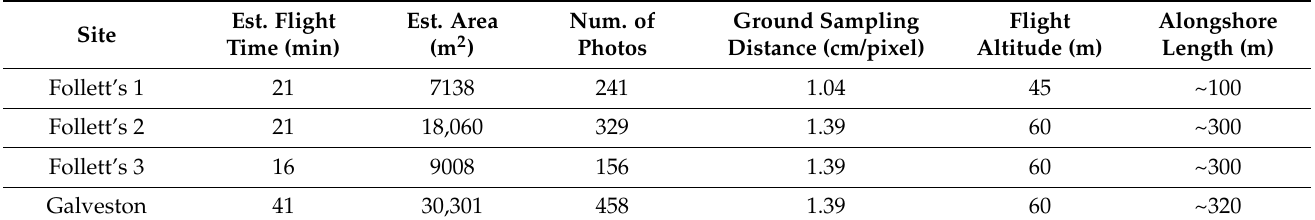
Table 2. UAV survey details for 5 pre-programmed missions completed on Galveston and Follett’s Islands on 18 May of